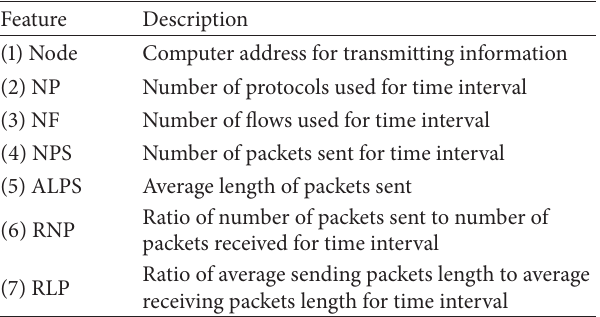
Figure 4: Effect of sampling on bot